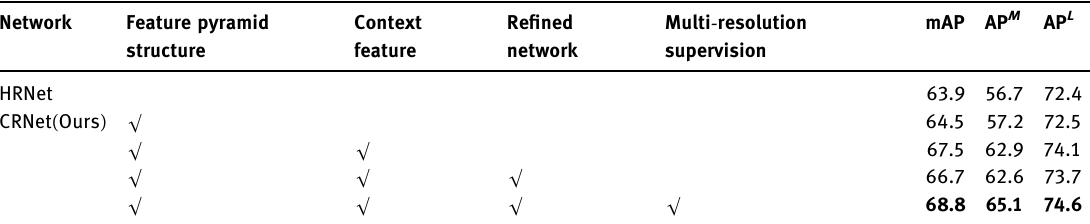
Table 3: Results of ablation experiments on the COCO validation set Network